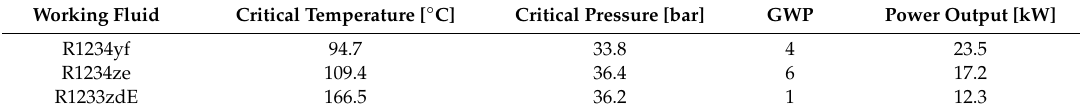
Table 6. Working fluids properties and performances of the LT–ORC.